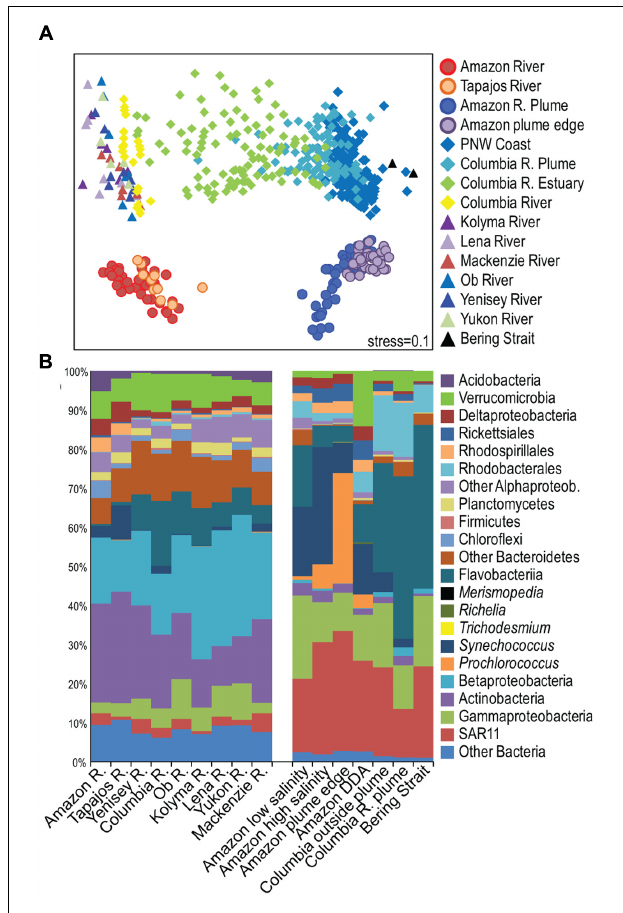
FIGURE 5 | (A) Multidimensional Scaling (MDS) diagram of Bray–Curtis similarity among bacterial communities in all samples collected for this study, communities from the Columbia River, estuary, plume, and surface ocean (Fortunato et al., 2013), and communities from six arctic rivers (Crump et al., 2009). (B) Average taxonomic diversity of bacterial communities in river, plume, and coastal ocean